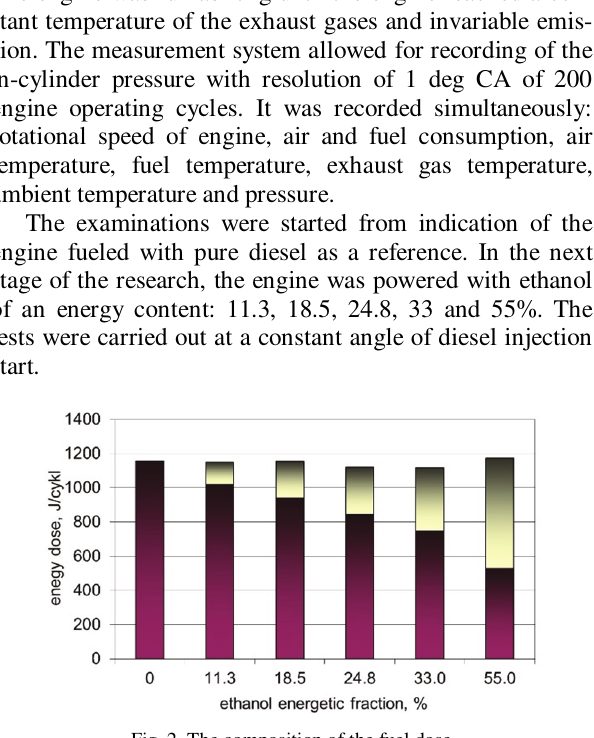
Fig. 2. The composition of the fuel dose